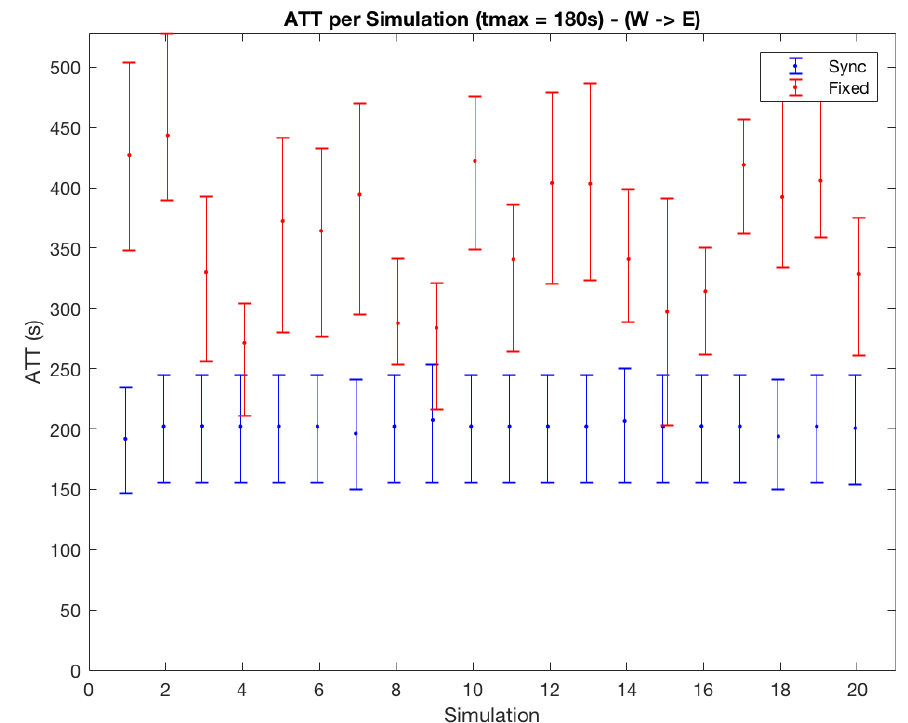
Figure 13. Travel time variation over different simulation runs: fixed time TLCS vs. synchronized ATLCS.